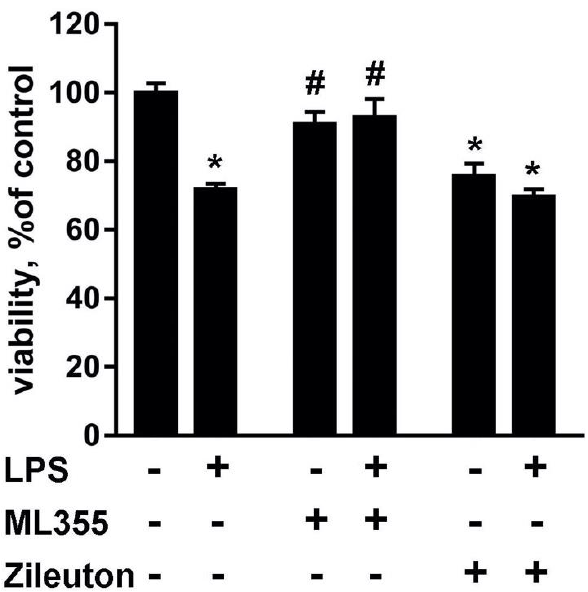
Figure 1. Lipid fraction from LPS-treated astrocytes changes the viability of neurons, which can be manipulated via astrocyte treatments with ML355 and Zileuton. The primary rat cortex neuron culture was incubated for 48 h with lipid fractions, which were prepared from an extracellular medium of astrocytes, activated for 24 h by LPS (100 ng/mL) only or with Zileuton (10 µ M) or ML355 (ML 10 µ M). Cell viability was measured using the MTT test. N = 12; *— p < 0.05, compared with the neurons treated with lipid fraction obtained from native astrocytes; # — p < 0.05, compared with the neurons treated with lipid fraction obtained from LPS-stimulated astrocytes.